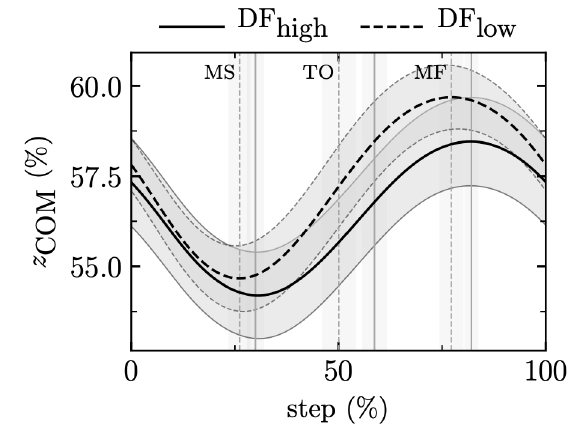
Figure 1. Vertical position of the center of mass ( z COM ) during the running step for the high (DF high ) and low (DF low ) duty factor running groups while running at 14 km / h. z COM is expressed as a percentage of participant’s height. The running speed represented is representative of all speed. MS: mid-stance, TO: toe-o ff , and MF: